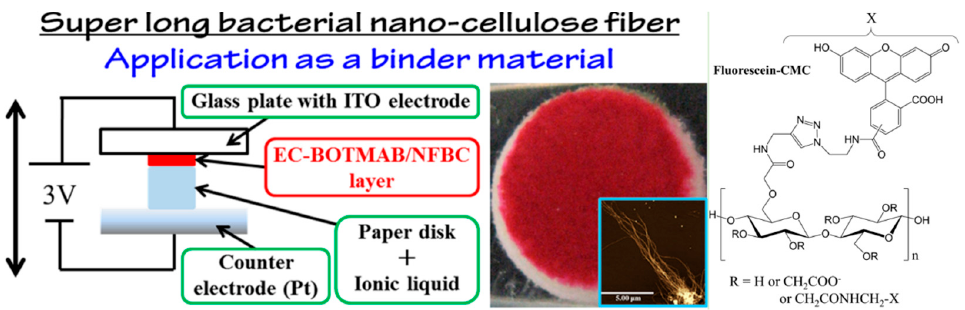
Figure 17. Experimental equipment for the coloring test and images of the EC-BOTMAB/NFBC. Reprinted with permission from [205]. Copyright 2019 American Chemical Society.